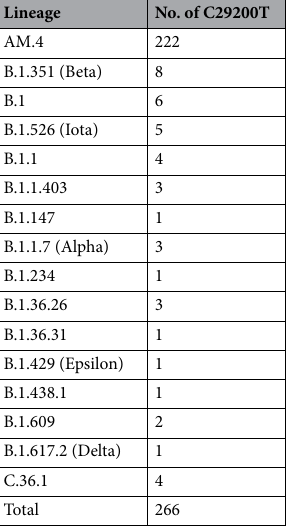
Table 2. SARS-CoV-2 lineages harboring C29200T mutation in Canada from data retrieved on May 22,